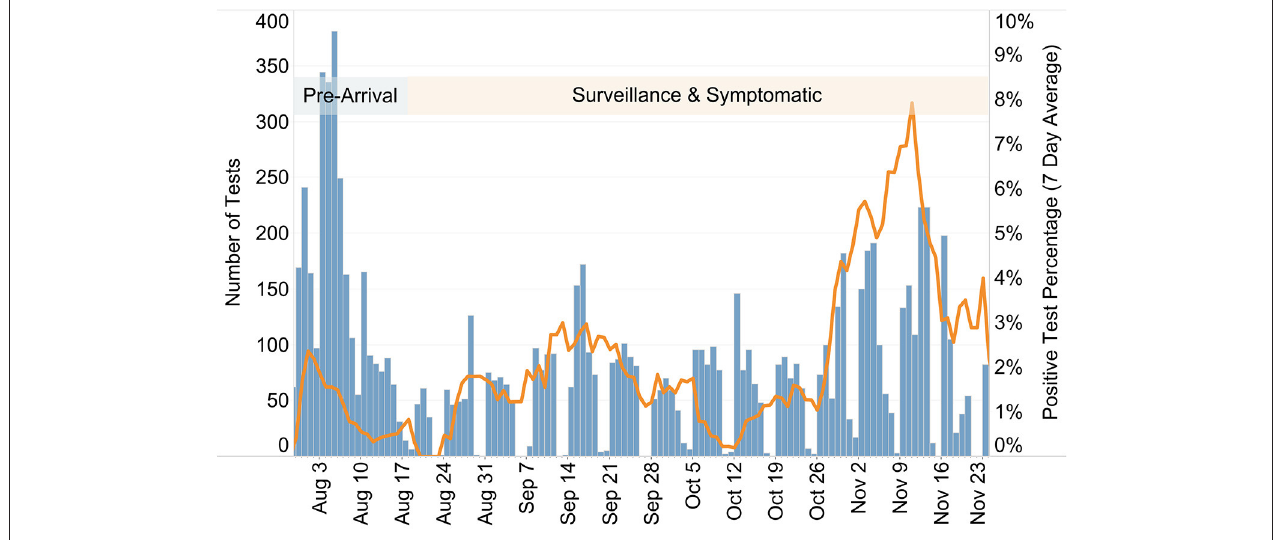
FIGURE 2 | Plot displaying the number of tests conducted each day (blue bars) and the 7-day running average of the positive-test percentage (orange line) at Hope College (MI) before and during the Fall 2020 semester. The semester began on August 17, separating pre-arrival testing from surveillance and symptomatic testing as